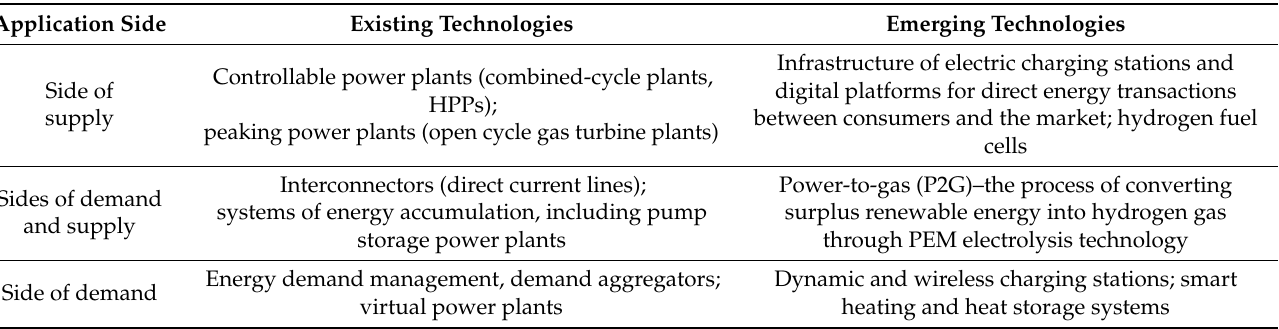
Table 2. Tools to enhance the flexibility of energy systems [28,47 – 50].